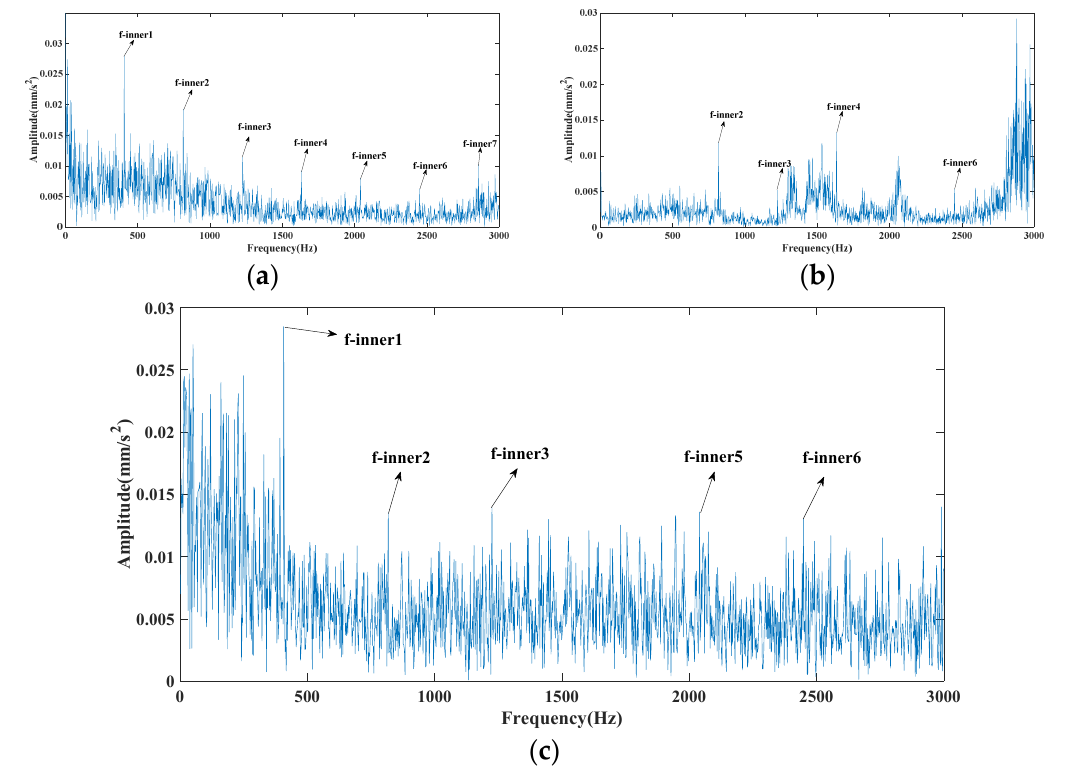
Figure 12. Comparison chart of the envelope spectrum results of three methods: CEEMDAN, ICEITDAN, and ITD. ( a ) ITD, ( b ) ICEITDAN, and ( c ) CEEMDAN.